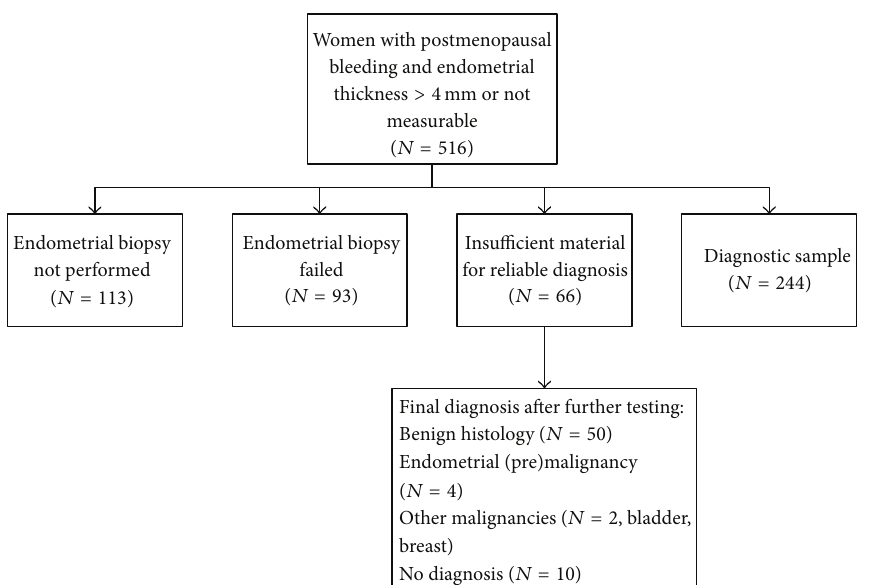
Figure 1: Flowchart of women with postmenopausal bleeding included in the original prospective cohort